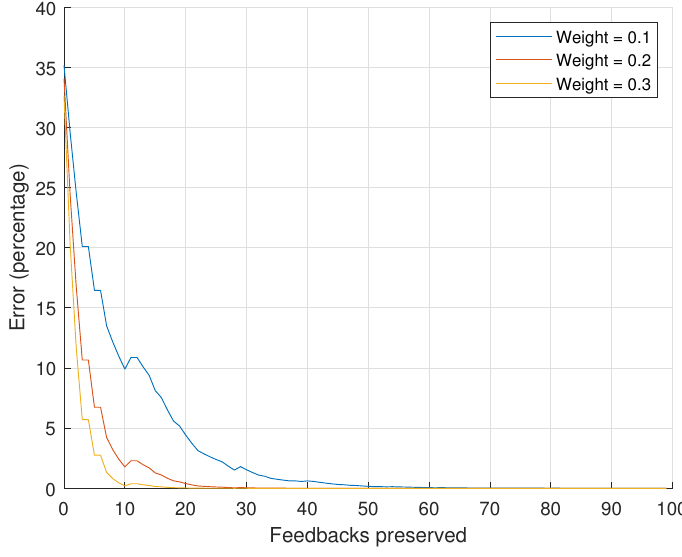
Figure 8. Error percentage for varying